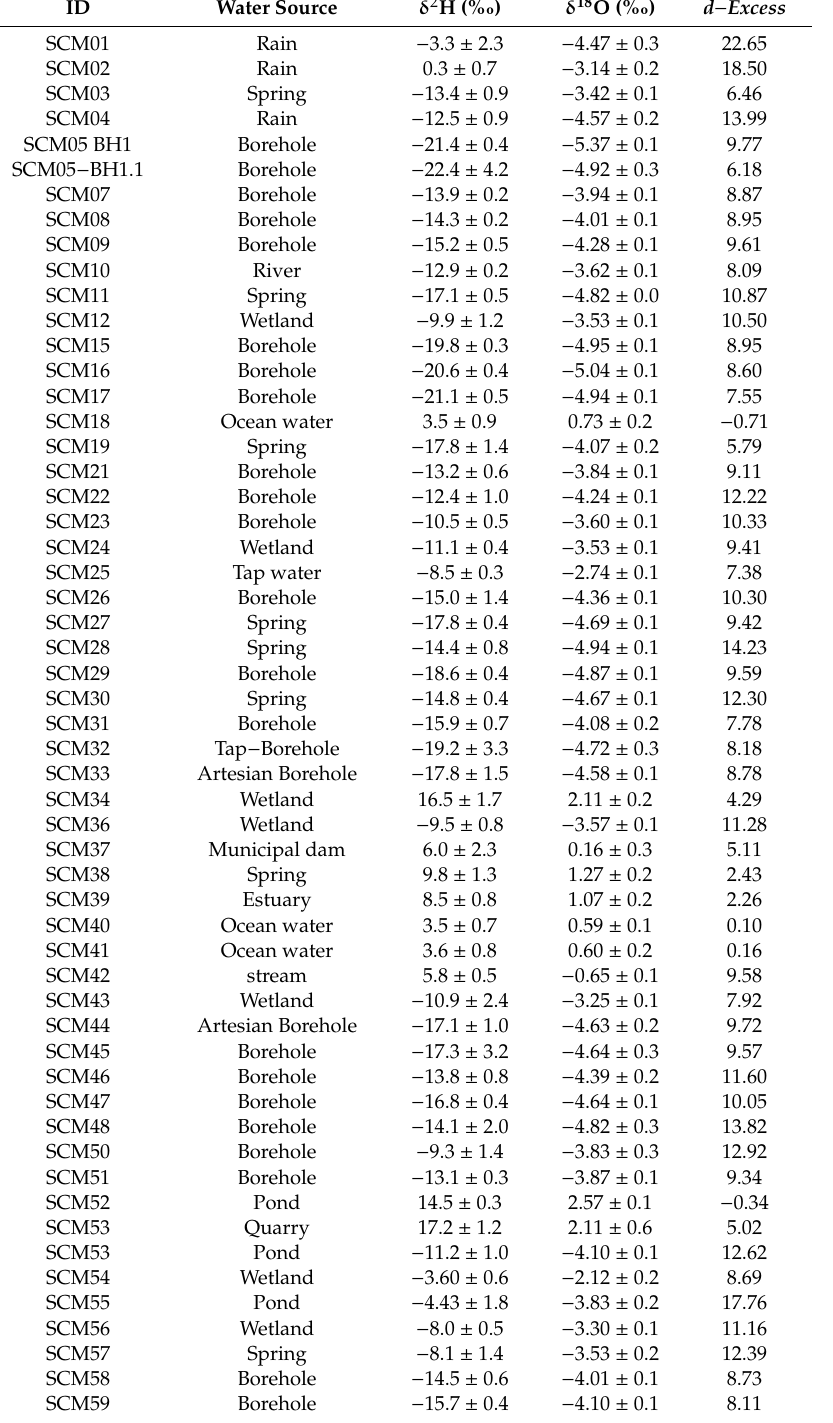
Table 4. Stable isotope values and d − excess in the Thyspunt